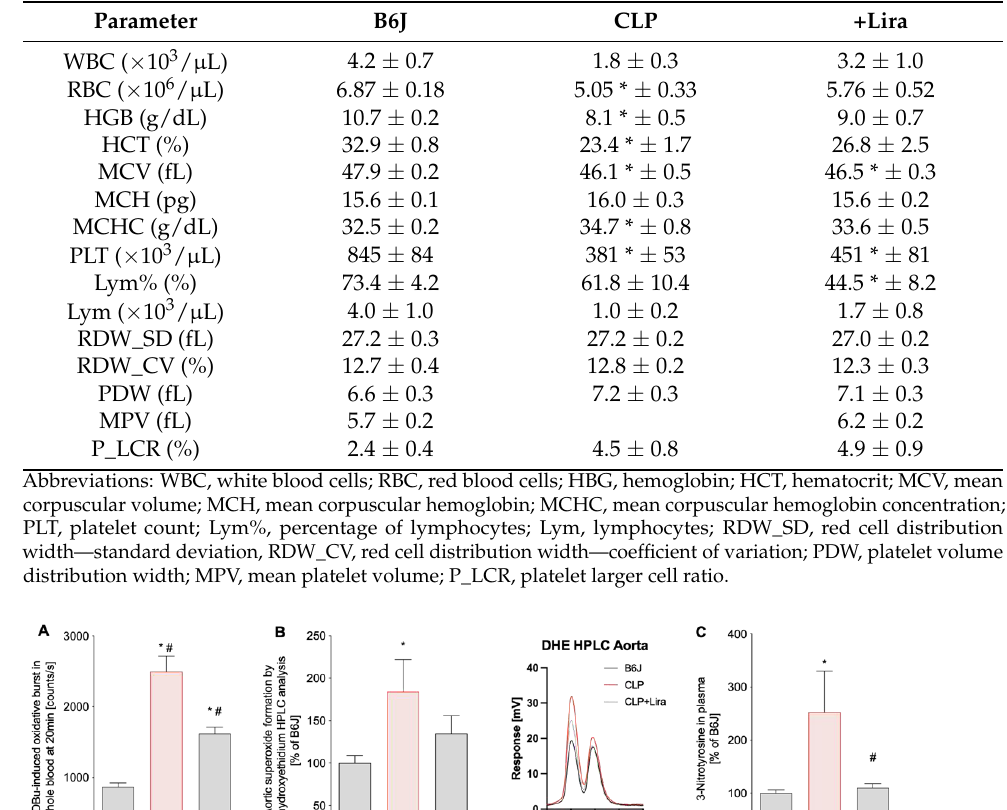
Table 1. Hematological parameters. Data are the mean ± SEM of 5–7 individual blood samples (each pooled from 3 to 4 mice). * p < 0.05 vs. B6J.